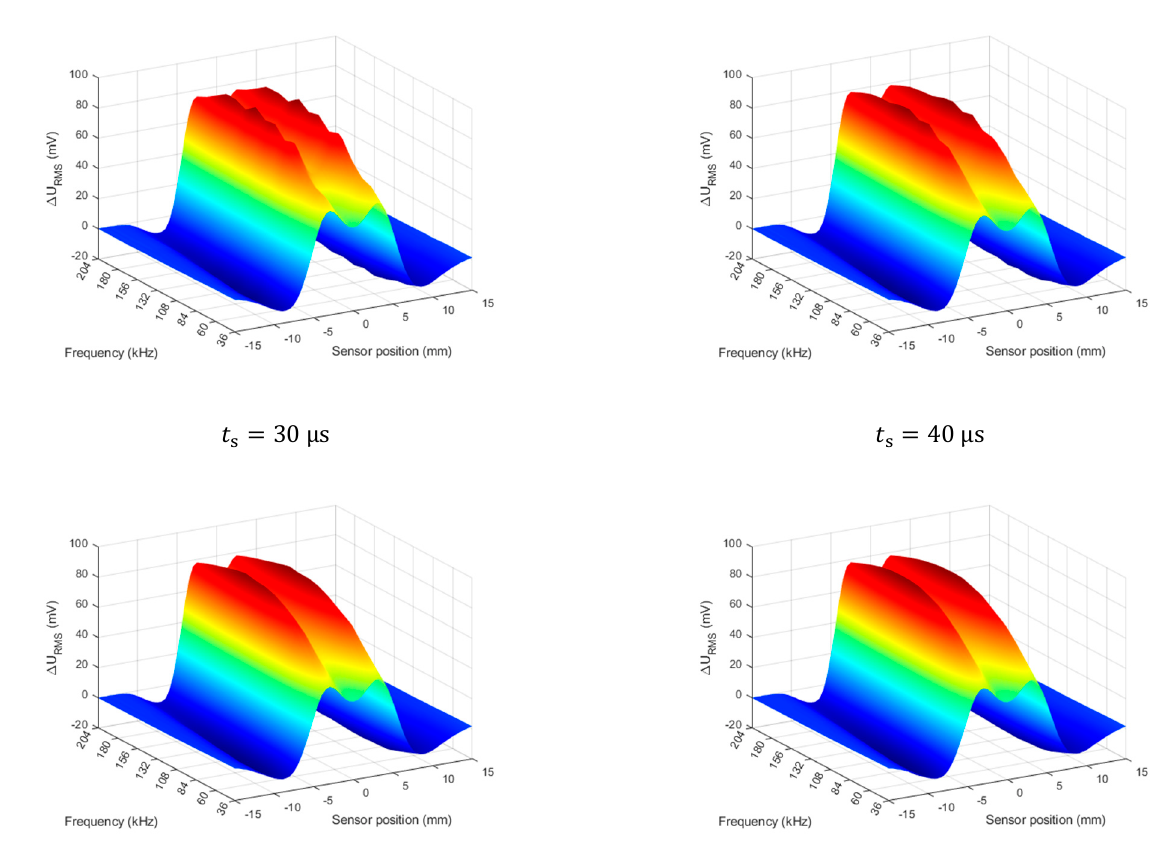
Figure 6. Effect of the transition state on the spectrogram. Flaw depth 60%. The t s is the start time of the data analysis window (the length of the window is constant).